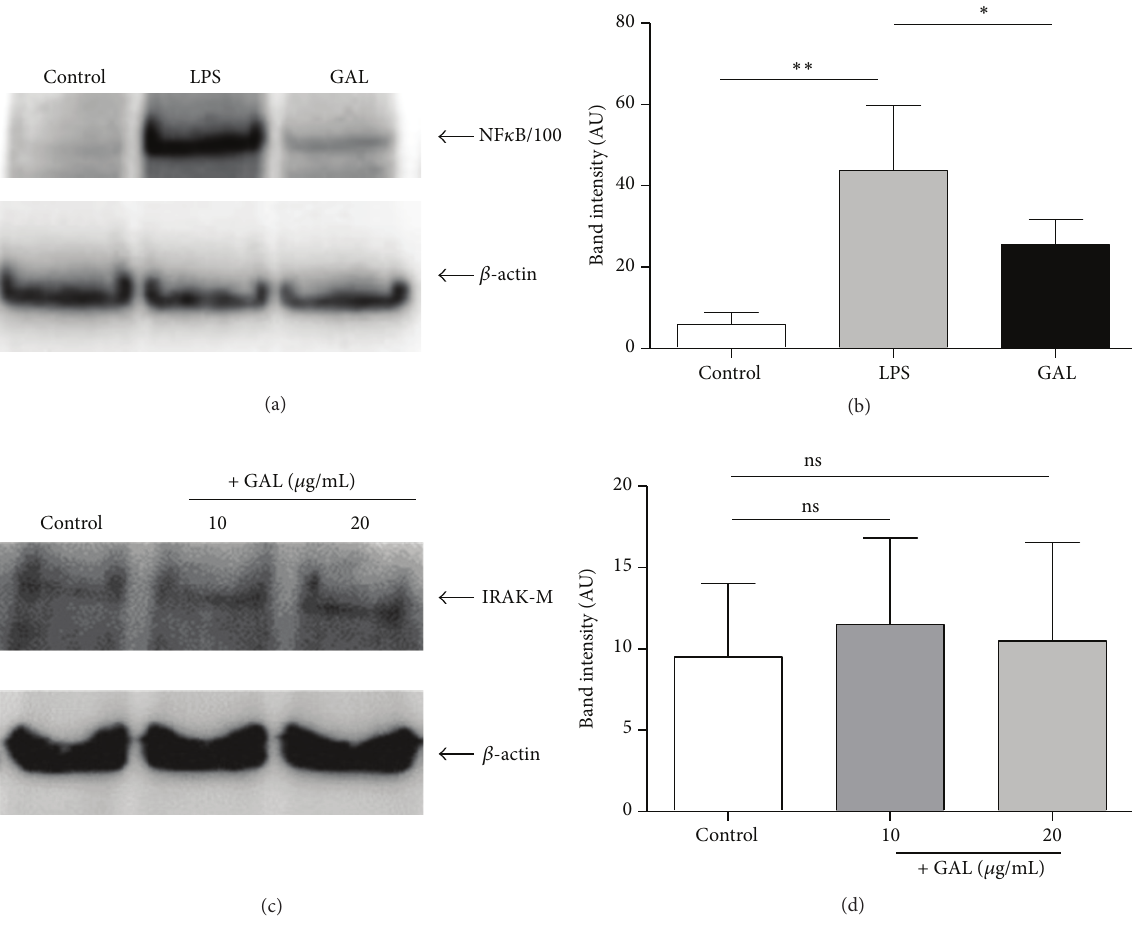
Figure3:TheNF 𝜅 B2/p100accumulationafterthefirstLPSorGALchallenge.Culturesofhumanmacrophageswerechallengedwith10 ng/mL LPS or 10 𝜇 g/mL GAL for 24 h. The controls were not treated. The levels of NF 𝜅 B2/p100 or IRAK-M and 𝛽 -actin were studied by Western blot analysis of the cytosolic fraction. (a) A NF 𝜅 B2/p100 standard blot is shown ( 𝑛 = 6 ). (b) Densitometry analysis: arbitrary units [AU] of NF 𝜅 B2/p100 bands are normalized with respect to 𝛽 -actin ( 𝑛 = 6 ). ∗ 𝑝 < 0.05 , ∗∗ 𝑝 < 0.01 compared with LPS. (c) A IRAK-M standard blot is shown ( 𝑛 = 3 ). (d) Densitometry analysis: arbitrary units [AU] of IRAK-M bands are normalized with respect to 𝛽 -actin ( 𝑛 = 3